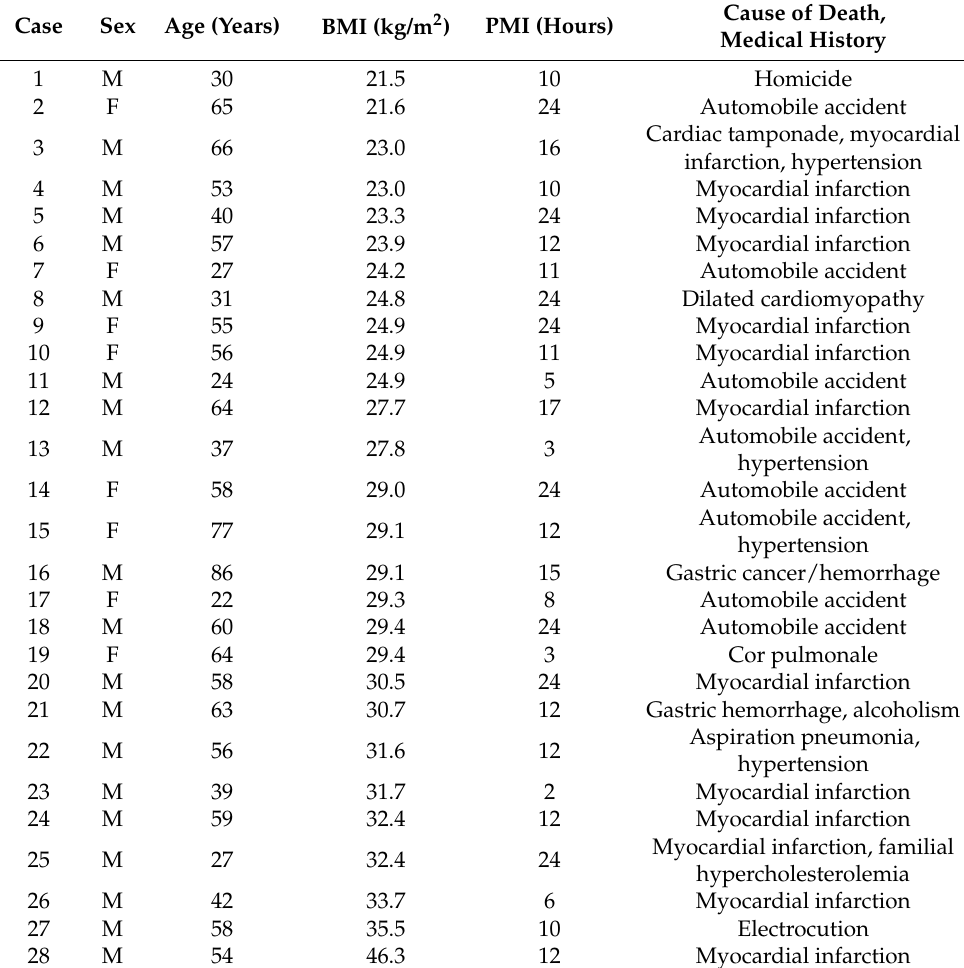
Table 1. Clinicopathological